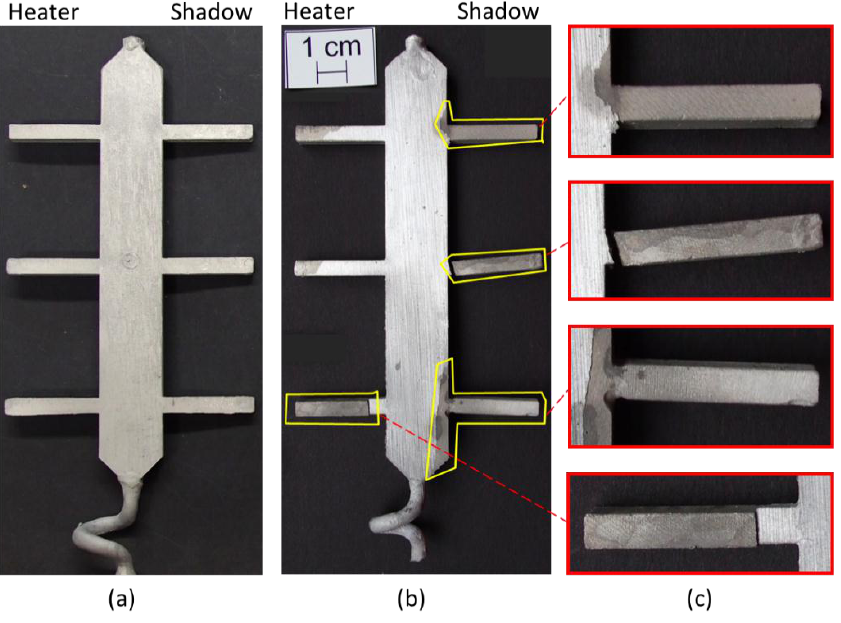
Figure 12. Typical macrostructure of directionally solidified samples: ( a ) CMSX-6; ( b ) Alloy3; ( c ) Magnification of stray grains in the platforms.